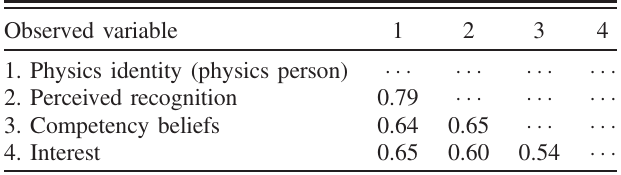
TABLE III. Zeroth order correlation coefficients of the con- structs in the mediation model.